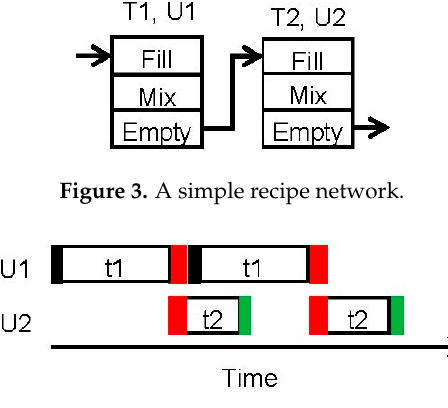
Figure 4. Schedule with non-zero transfer times.